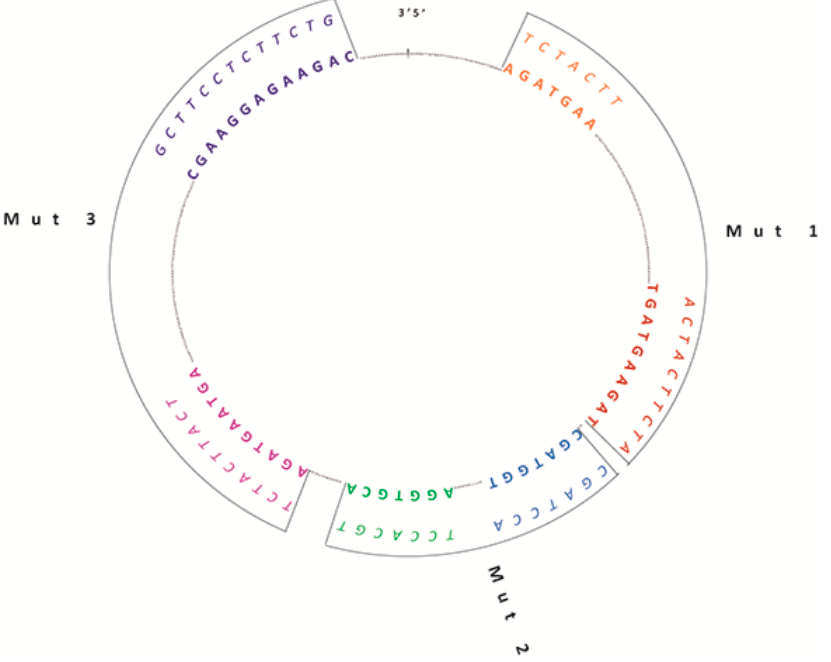
Table 1. Sequence, genomic localization and nucleotide (nt) position of mutated Serine and Arginine Rich Splicing Factor